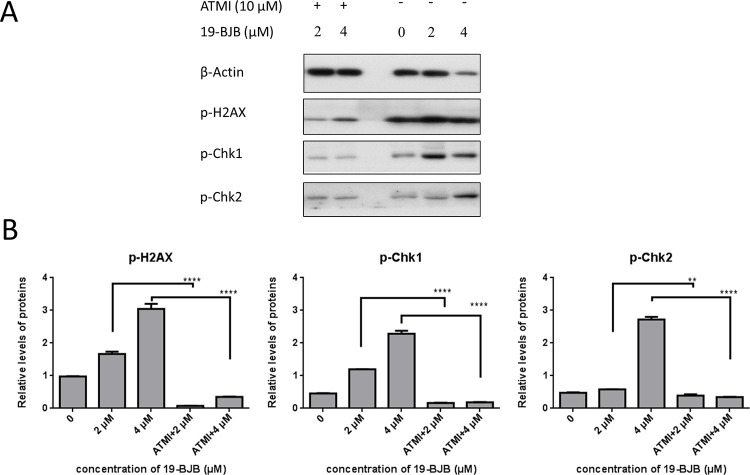
Western blots analysis of 19-BJB combined with ATMI.T24 cells were treated with 19-BJB in concentration of 0, 2, 4 μM for 48 h or ATMI (10 μM) 3 h before treating with 19-BJB for 48 h. And total cell lysates were analyzed for the expression of p-H2A.X, p-Chk1 and p-Chk2 (A). Equal protein loading was confirmed by reprobing membrane with β-actin after stripping. The relative levels of all proteins are performed (B) as means ± SD from triplicate samples for each treatment. **p < 0.01, ****p < 0.0001.